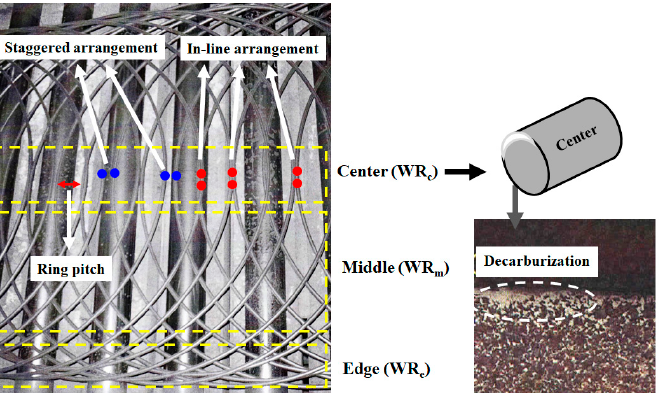
Figure 1. Schematic description of development trend in steel wire rod cooling system [6–12].